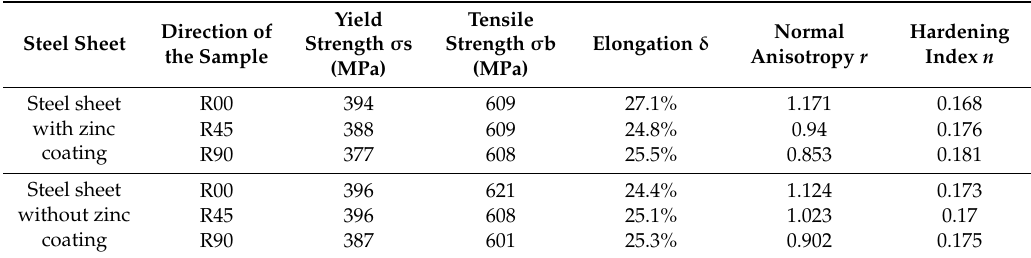
Table 1. Detailed results of uniaxial tensile tests.